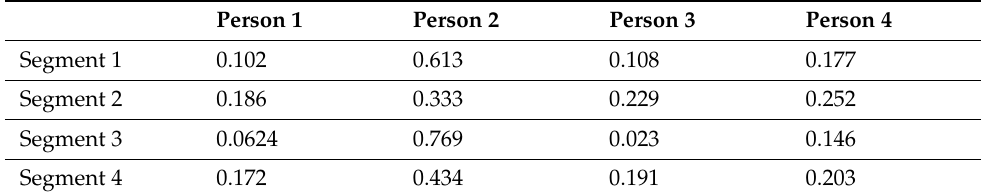
Table 1. The total distances between the four segments of every person and the fifth segment in the test space. Person 1 Person 2 Person 3 Person 4 Segment 1 0.102